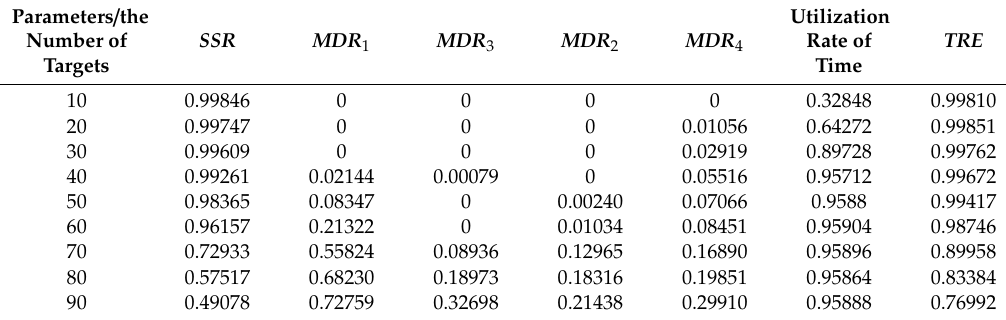
Table 5. Performance parameters of